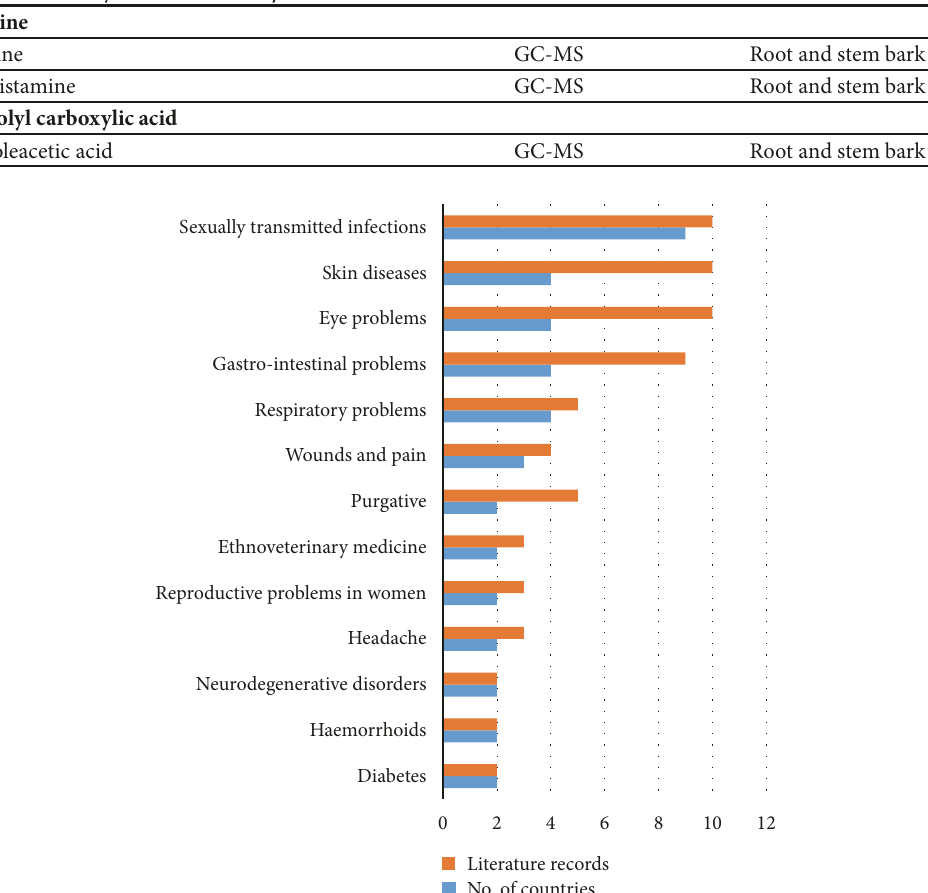
Figure 3: Major medicinal uses of Albizia adianthifolia in tropical Africa based on literature